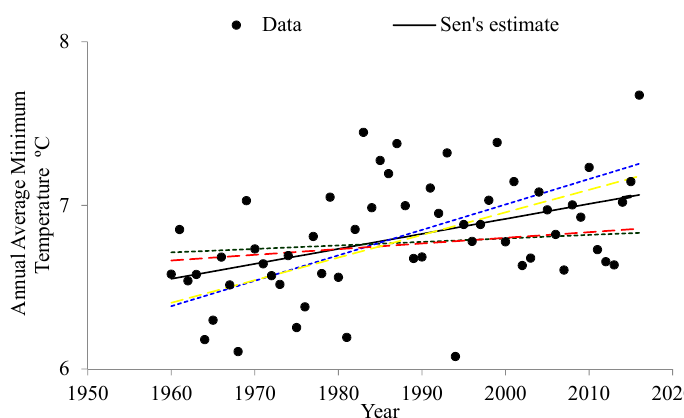
Figure 7. Mann–Kendall and linear regression slopes of season, October–December (OND), annual average maximum temperature for Maloti-Drakensberg for the period of 1960–2016.